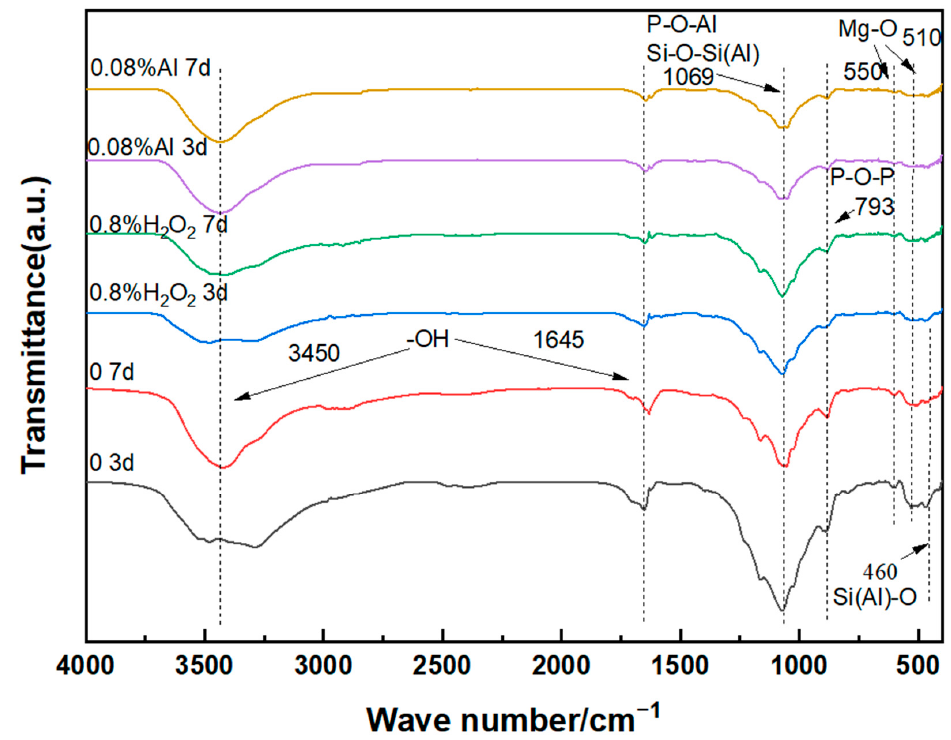
Figure 13. FTIR spectra of specimens prepared without a foaming agent and specimens prepared with different foaming agents.